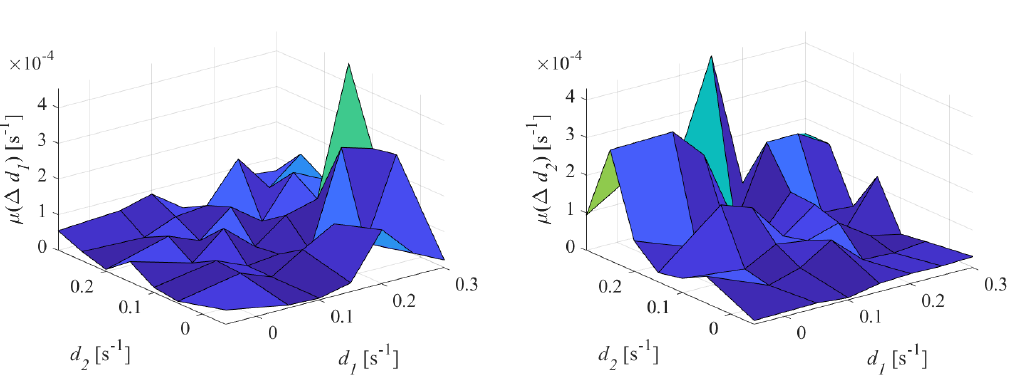
Figure 8. Mean of ∆ d versus damping coefficients obtained in numerical tests with noise and quantization; results for frequency f 1 ( on the left ) and f 2 ( on the right